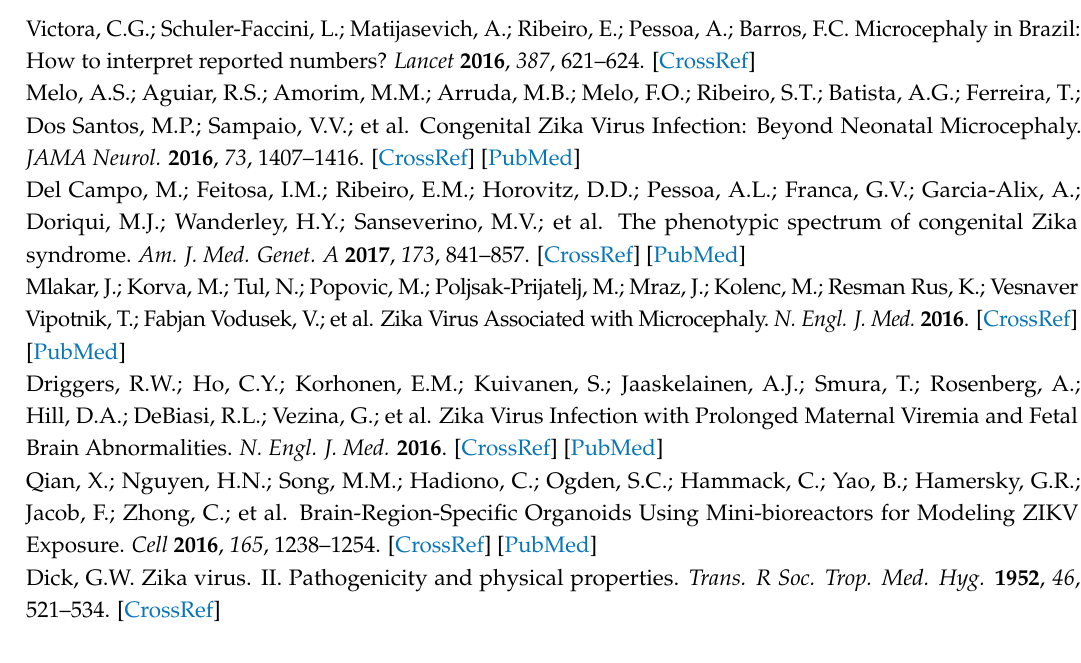
Figure S1: Representative pictures of the immunostaining assay to measure caspase 3 cleavages (A) as shown in Figure 2C; Figure S2: Correlation of viral attachment and viral infection between chimeric viruses and their parental viruses in A549 cells; Figure S3: Effect of Adv-prM expression on ZIKV-induced cell viability in different cell